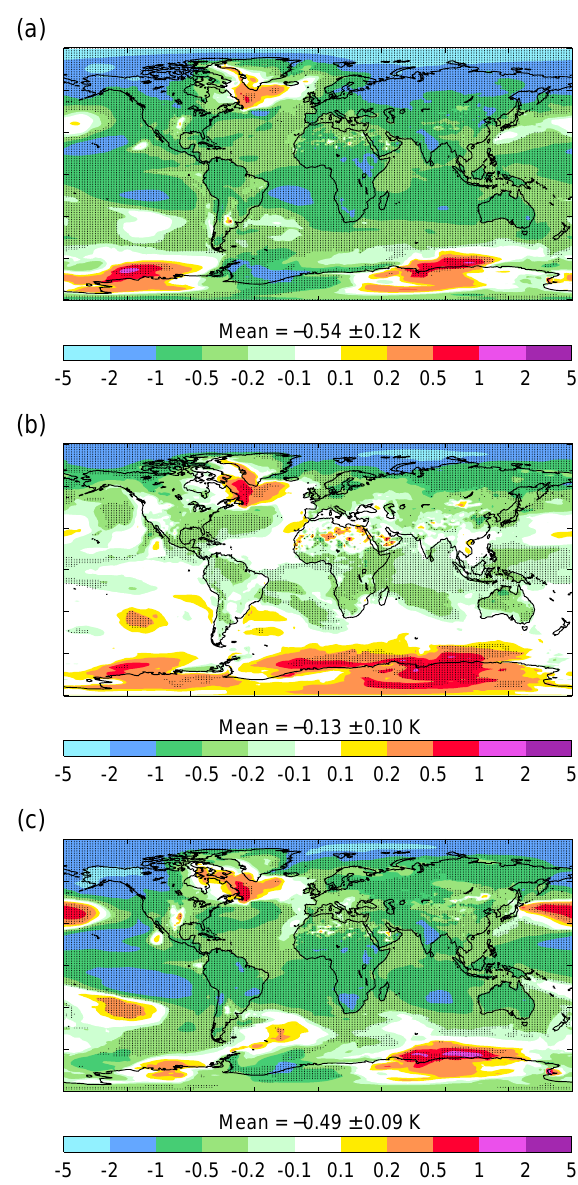
Fig. 4. (a) Mean 2040-2069 change in near-surface air tempera- ture (K) with respect to RCP4.5 when using the I-mask pattern for emitting geoengineered sea-spray. (b) As (a) but using the D-mask emission pattern. (c) As (a) but using I-mask NSA . Areas where the changes are significant at the 5% level are